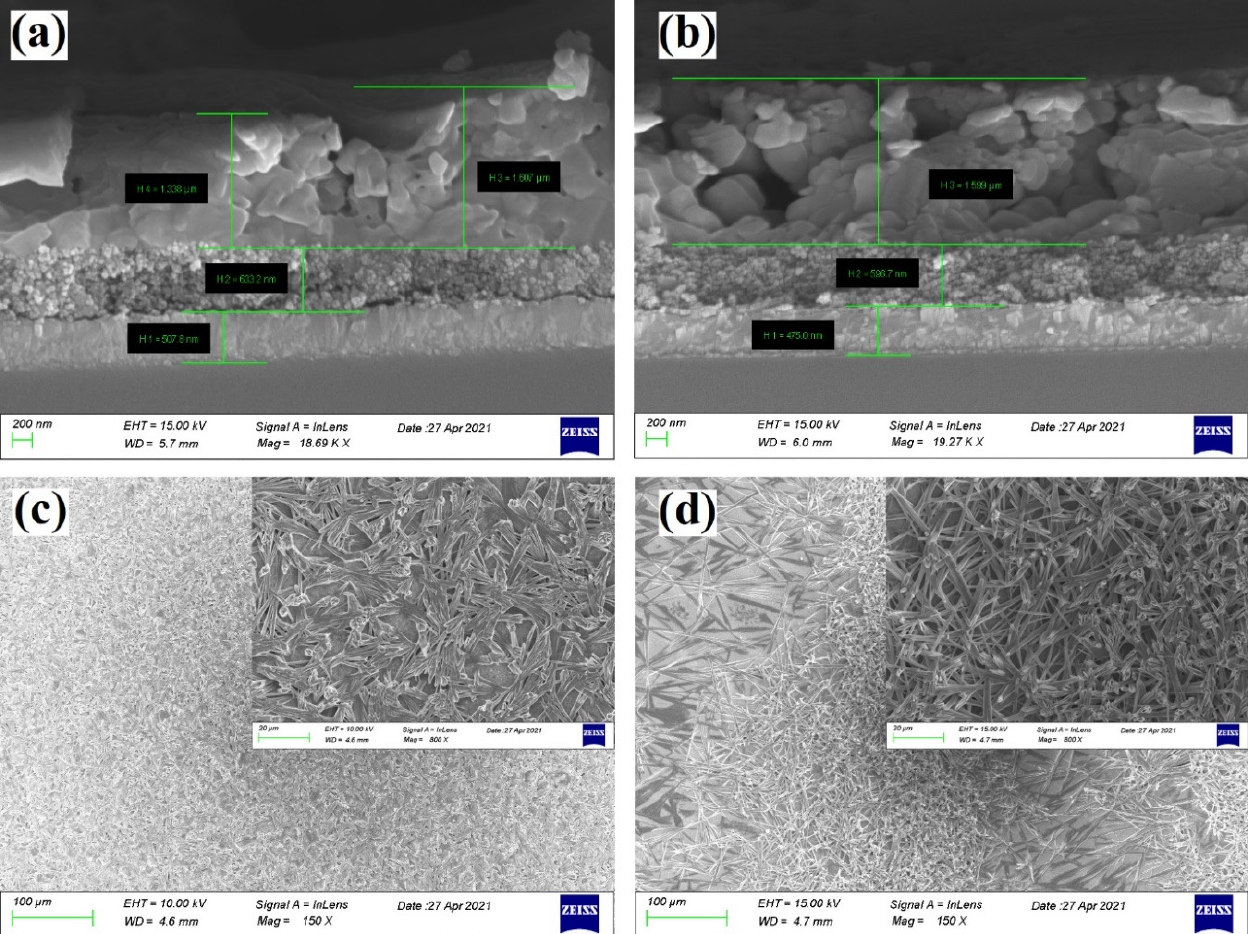
Figure 3. ( a , b ) Cross-section SEM images of the perovskite layer on the m-TiO 2 layer and ( c , d ) top-view SEM images of the perovskite layer fabricated using the spin-coating and inkjet-printing techniques, respectively.